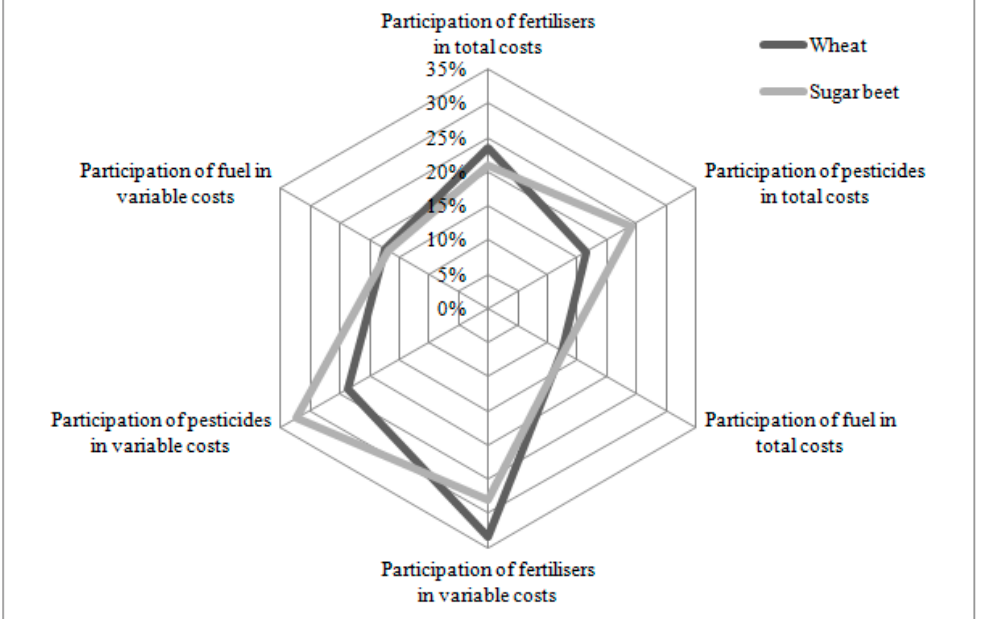
Figure 2. The most important elements of variable costs and total costs. Energies 2020 , 13 , x FOR PEER REVIEW